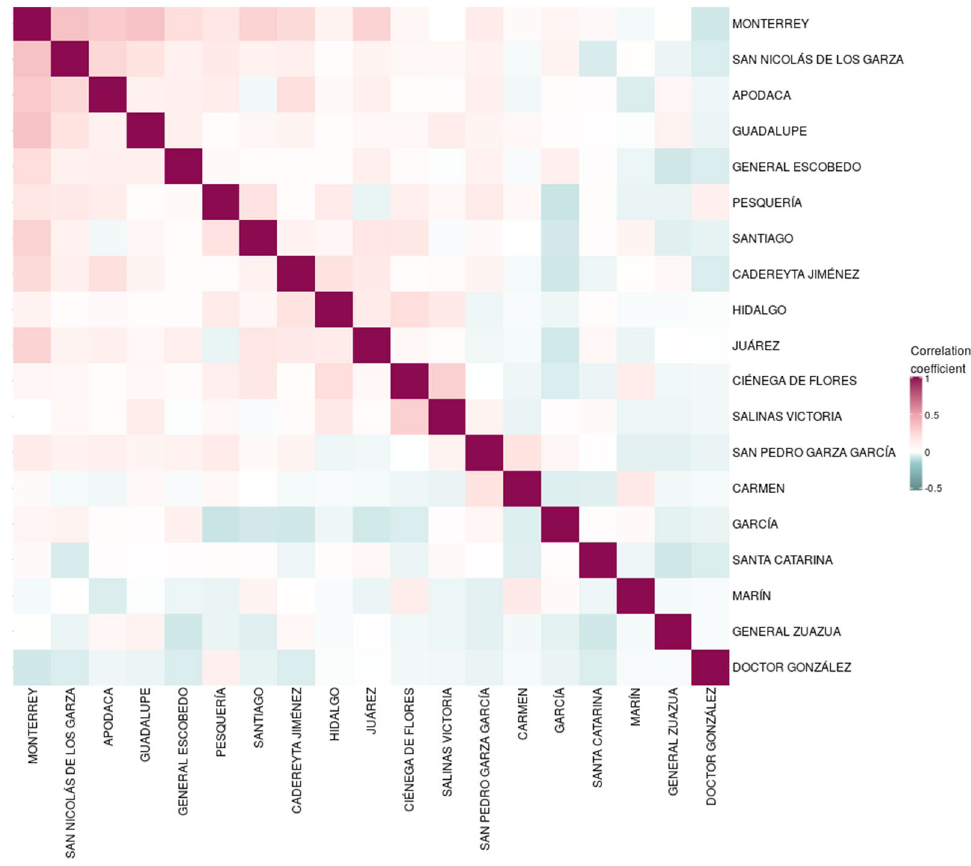
Figure 4. Correlation of homicides in the cities of MMA. This heatmap represents the Pearson correlation coefficient of the homicide time series of the 19 municipalities that compose the MMA. Pink squares show positive correlation, meanwhile negative correlations are depicted in blue.